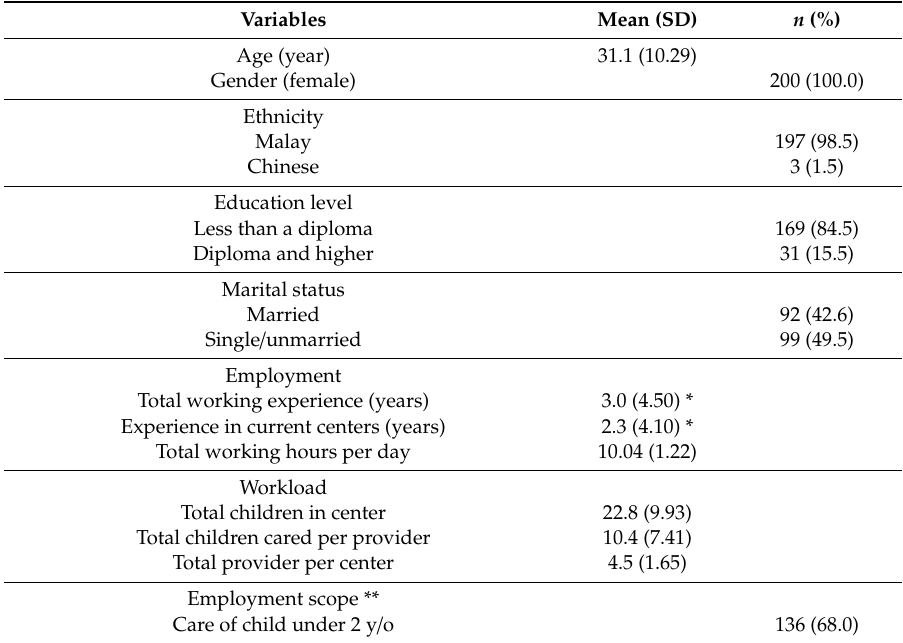
Table 2. Sociodemographic characteristic of child care providers (n =